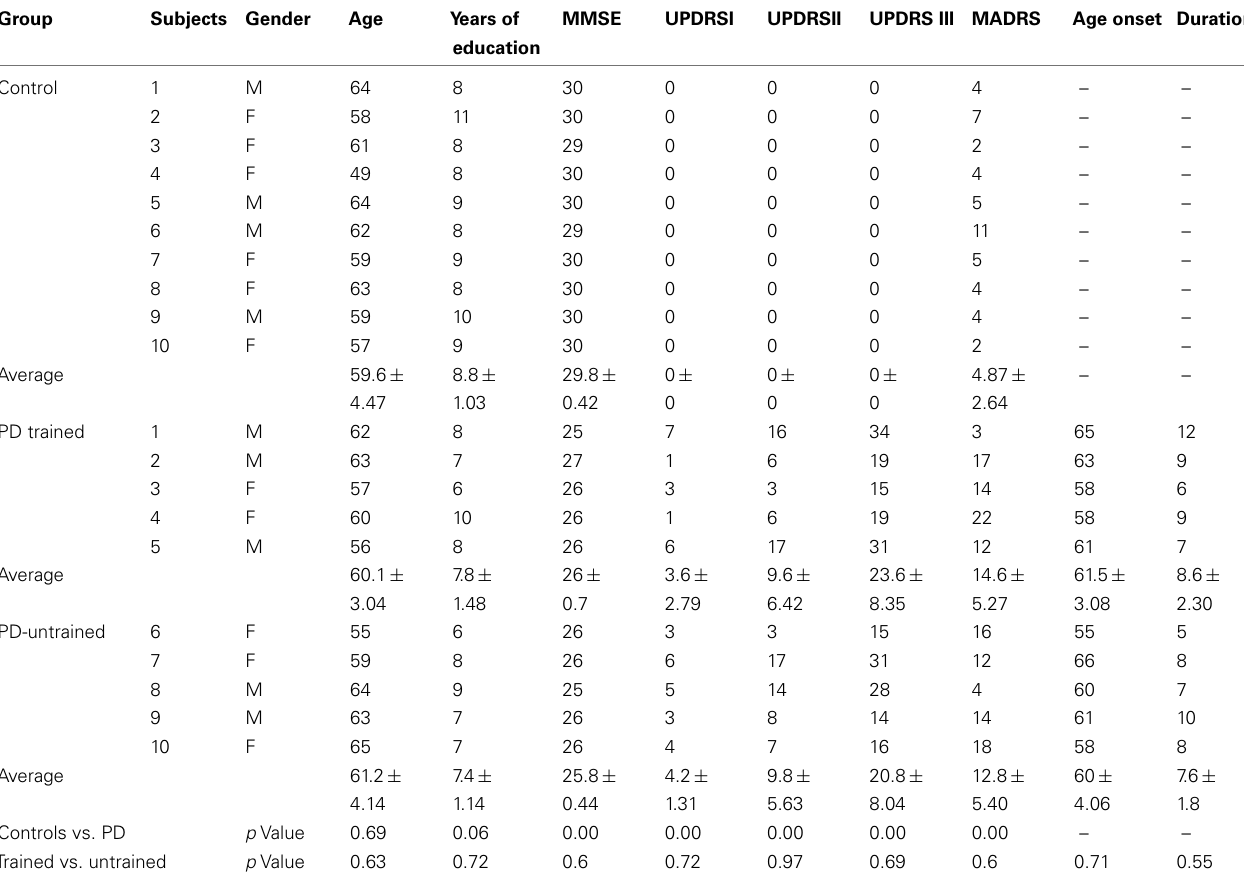
Table 1 | Overview of the participants indicating the experimental group, subject number, demographics, and test scores.